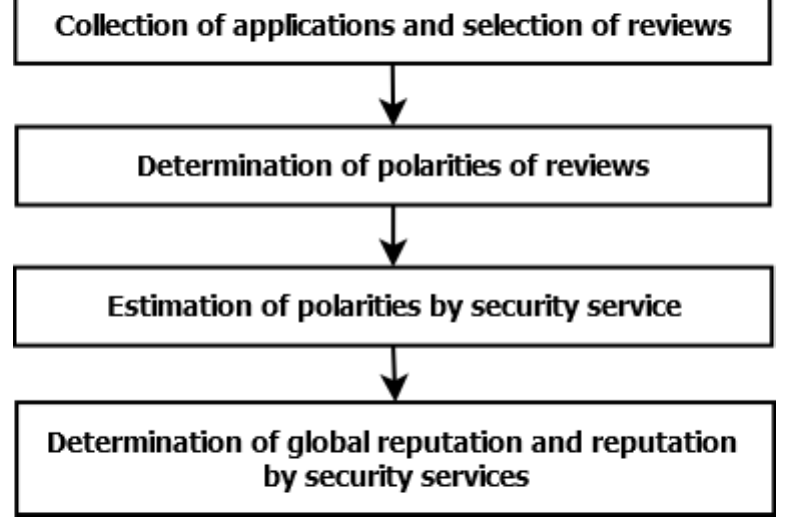
Figure 1. Research